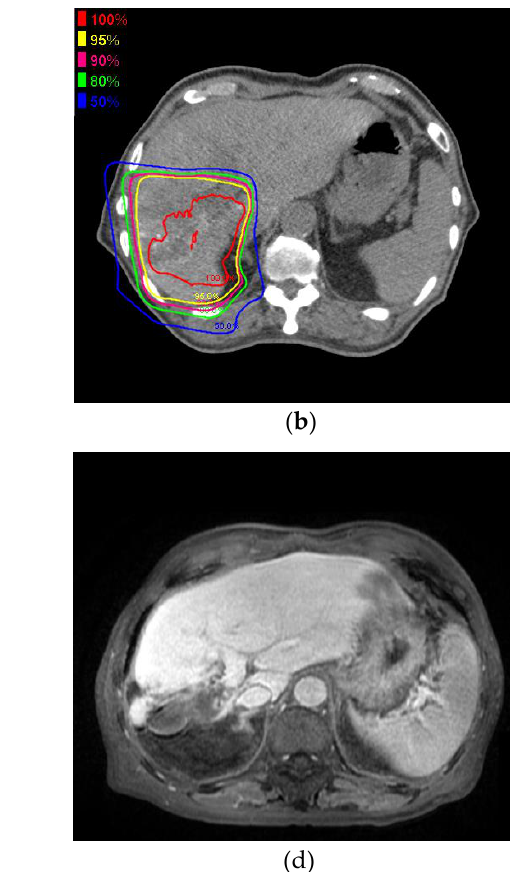
Figure 1. Kaplan – Meier estimates of overall survival (OS), progression-free survival (PFS), and local tumor control (LTC) among all 40 patients. The median OS period was 20.8 months (range, 1.3 – 72.3 months). The median PFS period was 9.8 months (range, 0.0 – 57.2 months). The 2-year OS, PFS, and LTC rates were 76%, 60%, and 94%, respectively.